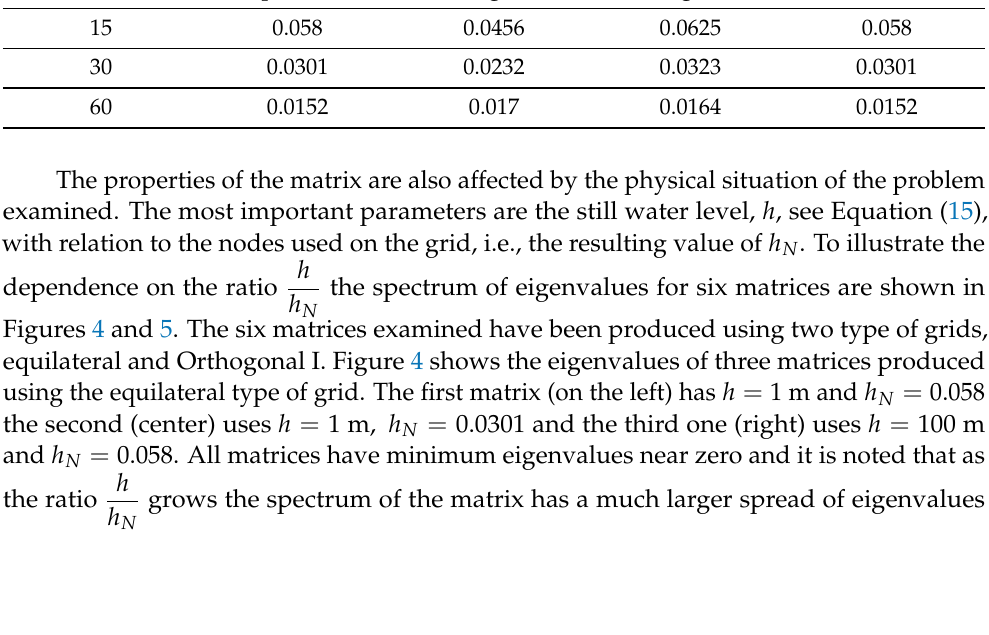
Table 2. The h N values for the matrices produced for L x = L y = 1 m with different N x . N x